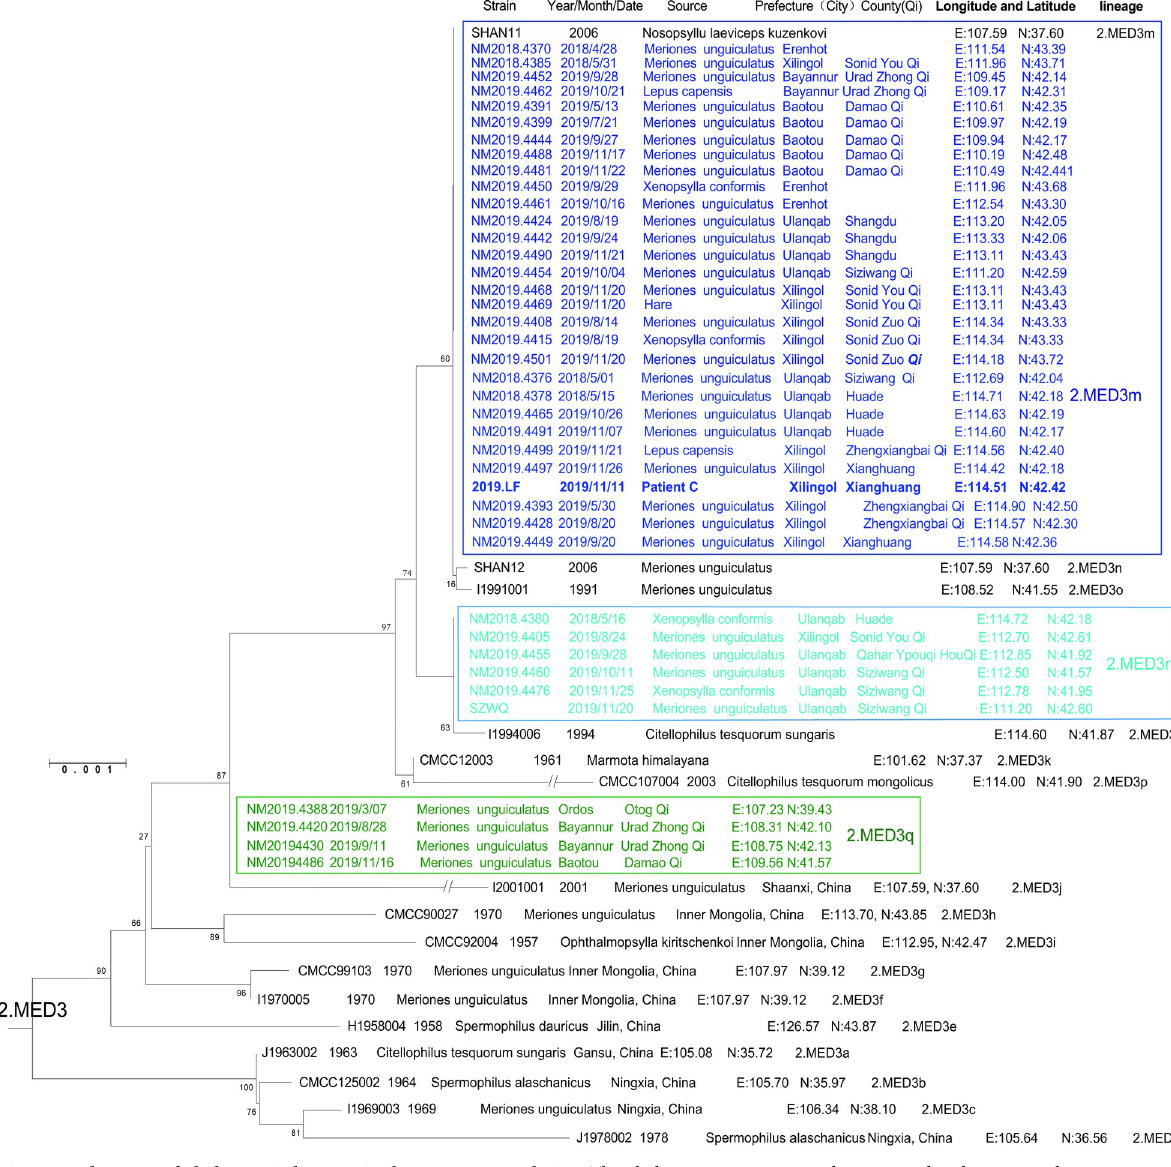
Fig 2. Dendrogram of phylogenetic lineages in the 2.MED3 population. The phylogenetic structure and corresponding lineages in the 2.MED3 population was determined from the SNP assignments by the maximum likelihood method.